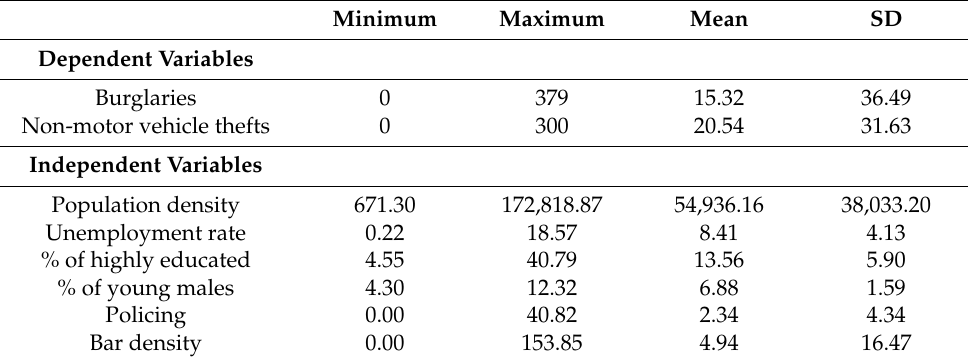
Table 1. Descriptive statistics of the dependent and independent